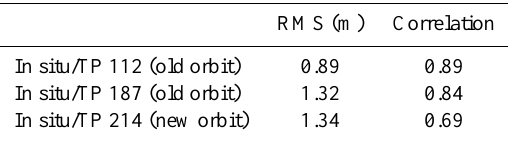
Table 1. Comparisons between the gauge records from Salekhard and the water levels derived from T/P